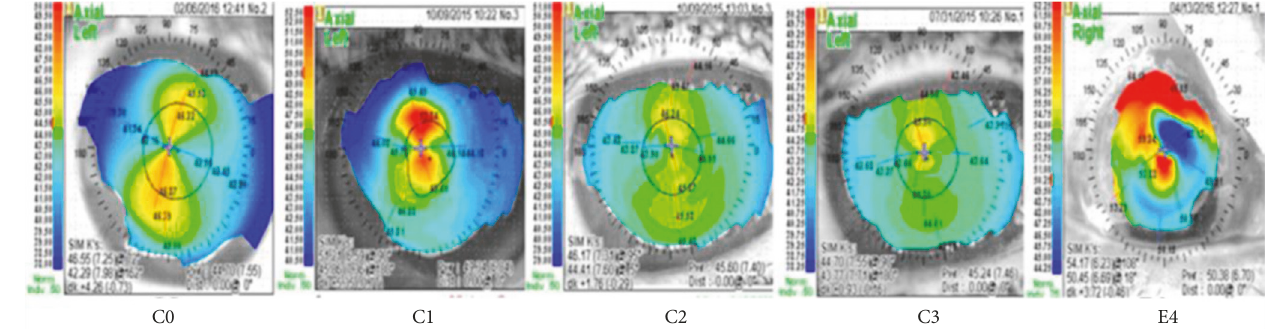
Figure 1: Representative images of Table